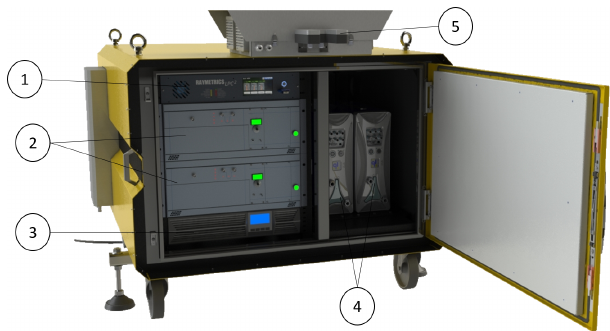
Figure 6. The enclosure with (1) the LPC unit, (2) the Licel rack with the TRs and the master trigger control, (3) the UPS, (4) the power supplies of the lasers, and (5) the precipitation